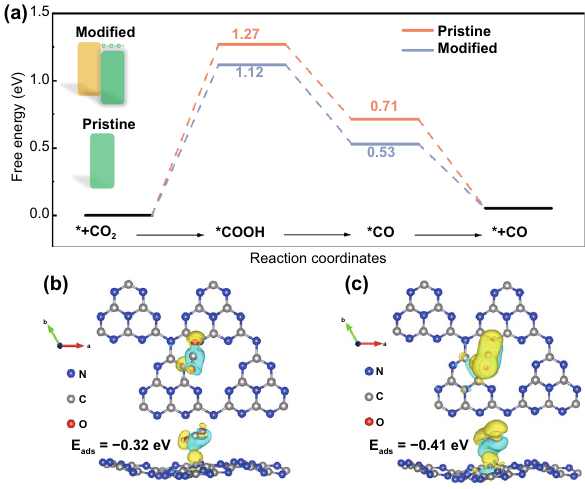
Fig. 7 a Free energy profiles of photocatalytic CRR to CO. Differ- ence charge density diagrams of CO 2 adsorption on the b pristine and c modified g-C 3 N 4 . The isosurface value is 5 × 10 4 e Å